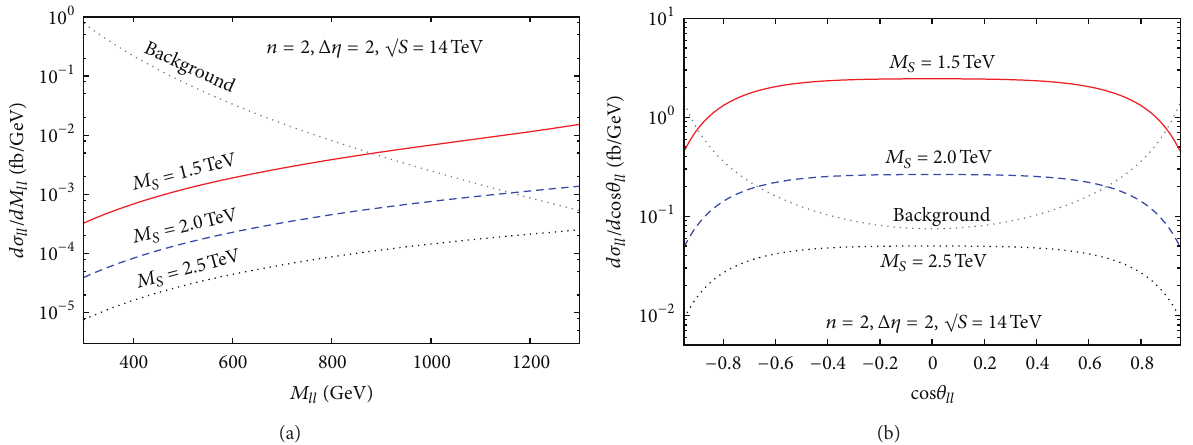
Figure 8: The total signal cross-sections ( 𝑝𝑝 → 𝑋 + 𝑙𝑙 + 𝑌 ) in dilepton channel ( 𝜎 𝑙𝑙 ) as a function of 𝑀 𝑆 at the 14TeV LHC. In (a), we plot Δ𝜂 = 1.5, 2.0, 2.5, and 3.0 for 𝑛 = 2 . In (b), we plot 𝜎 𝜎 𝑙𝑙 for defined in (17).